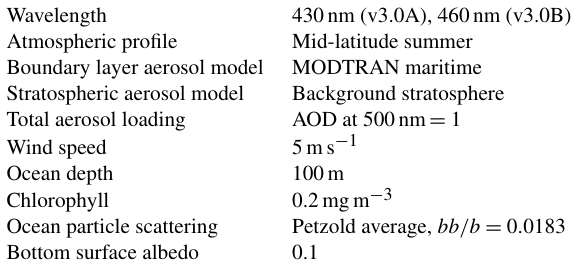
Table 1. Additional settings for the COART model used to simulate ocean reflectivity. “Atmospheric profile” refers to the distribution of total precipitable water, O 3 , CO 2 , and CH 4